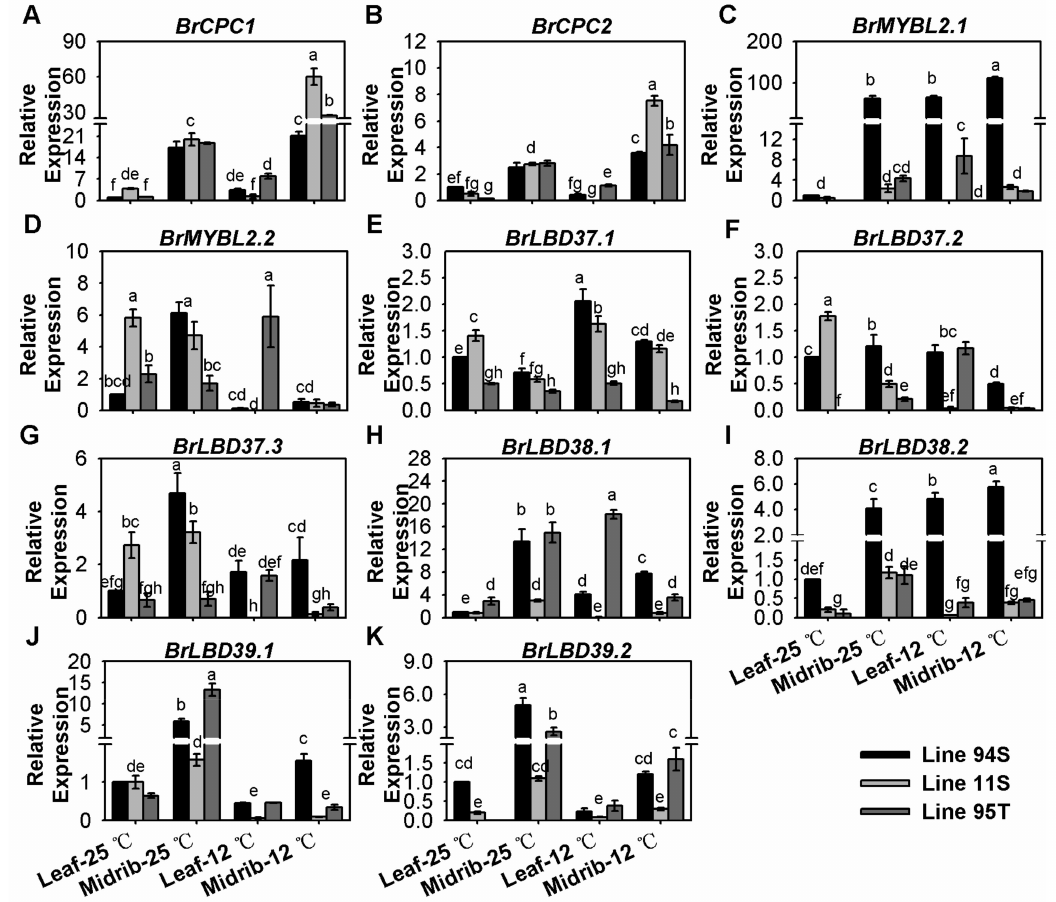
Figure 6. Expression of negative regulatory gene s in the seedlings of three Chinese cabbages under low -temperature treatment. ( A – D ) relative expression of R3-MYB regulatory genes; ( E – K ) relative expression of LBD (LATERAL ORGAN BOUNDARY DOMAIN) genes. Plants of three lines were grown under a 12-h light photoperiod at 25 ◦ C, 125 mmol m − 2 s − 1 ; 28-day seedlings were treated at 12 ◦ C for 15 days and the seedlings that stayed at 25 ◦ C with same light condition were treated as the control. Seedling leaves were divided into the midribs and the leaves, and leaves of Line94S at 25 ◦ C served as the control. Values are presented as means ± SD ( n = 3). The di ff erent letters above each column are significantly di ff erent at p < 0.05 by Duncan’s